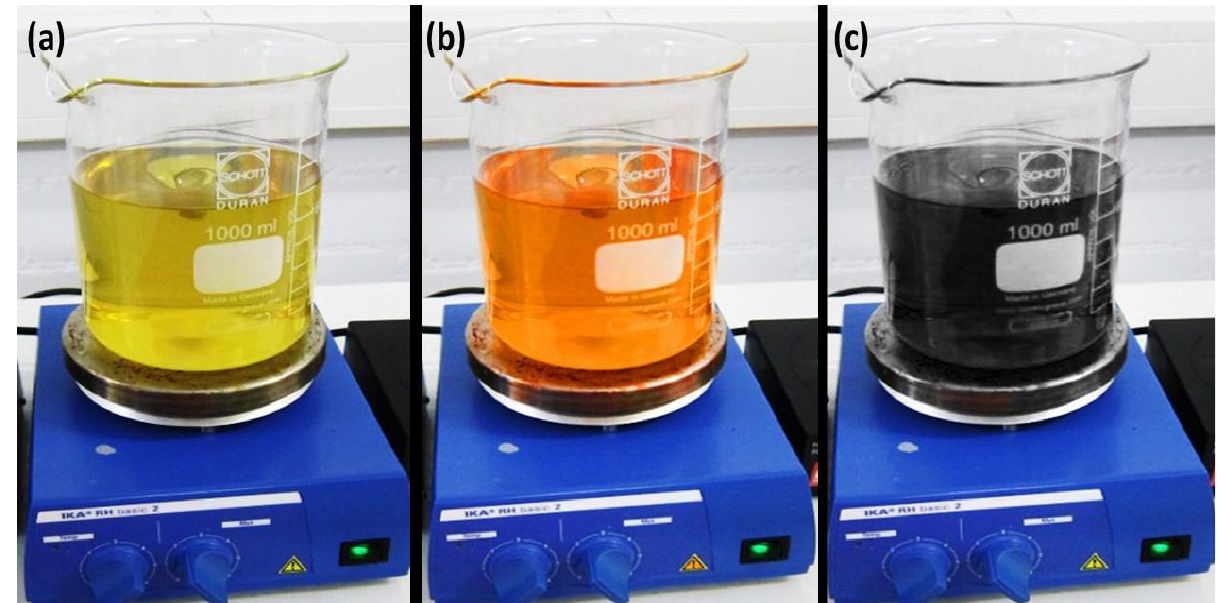
Figure 1. Synthesis process of Ag-NPs; ( a ) yellow color appeared during the mixing of silver nitrate and glucose with diethylamine ( b ) yellow color of the solution change to orange and ( c ) the orange color of the solution is turned to black indicating the formation of Ag-NPs